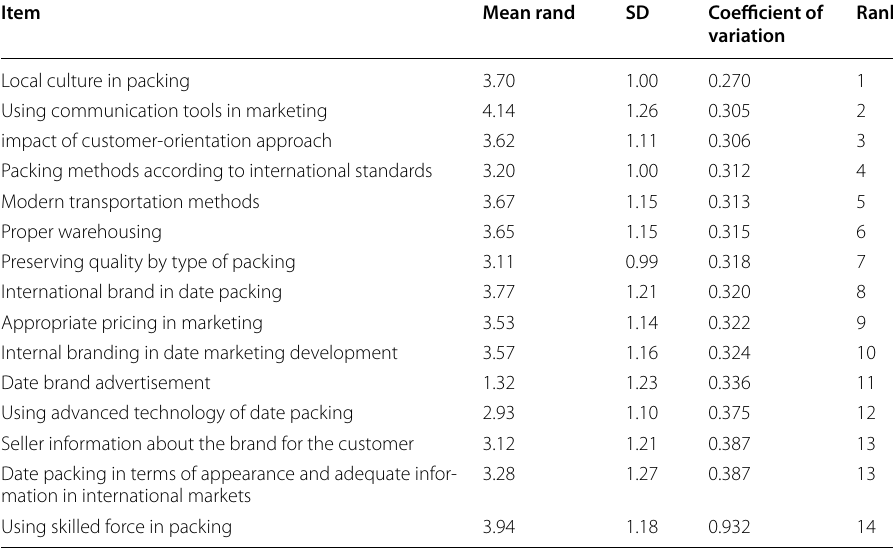
Table 1 Descriptive statistics for marketing in processing industries Item